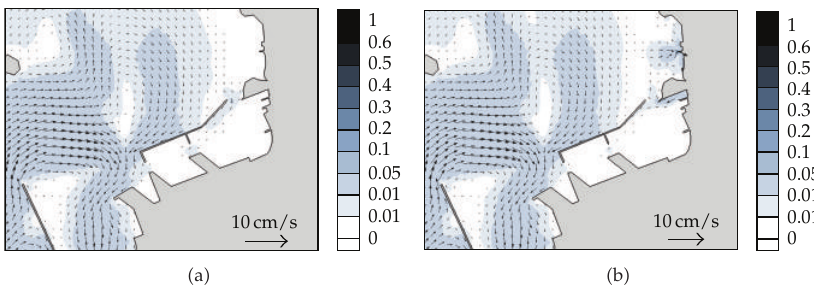
Figure 21: Mean field currents in the simulation with power plant turned o ff (cid:3) a (cid:4) and power plant turned on (cid:3) b (cid:4) . Velocities in